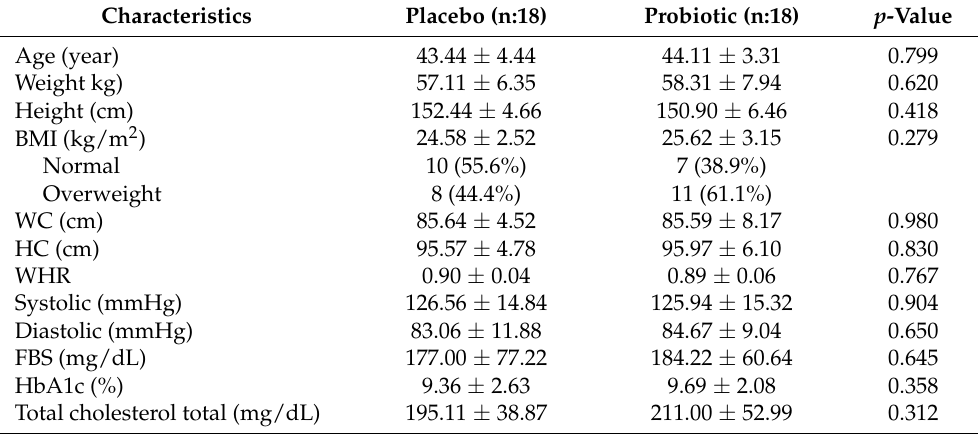
Table 2. Characteristic of study subjects at